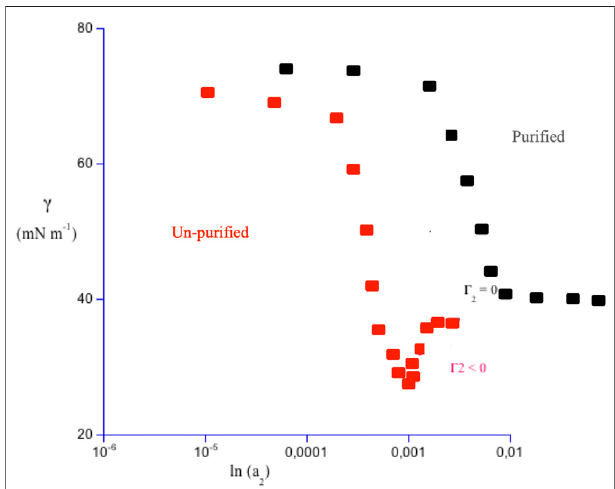
FIGURE 1 | Plot of surface tension, γ , in mN m − 1 , versus solute activity, a 2 ,inlogarithmicscaleandinarbitraryunits,foracommercialsodiumaryl-alkyl sulfate containing 1.0 w% octanol, in red. Γ 2 , the tangent of γ vs. ln a 2 , is practically null only well above the critical micellar concentration, cmc . Around that threshold, it can be null, positive, or negative. Surface activity in un-puri fi ed systems spans a concentration range and differs from that of the pure surfactant, black symbols. Thelowconcentration regime isfollowed bya saturation one. There γ reachesa real plateau when a 2 is higher than the cmc . In puri fi ed samples, thus, both the minimum and the inversion in the sign of Γ 2 donotoccur.Abovethe cmc theinterfaceissurfactant-saturatedandmicelles begin to